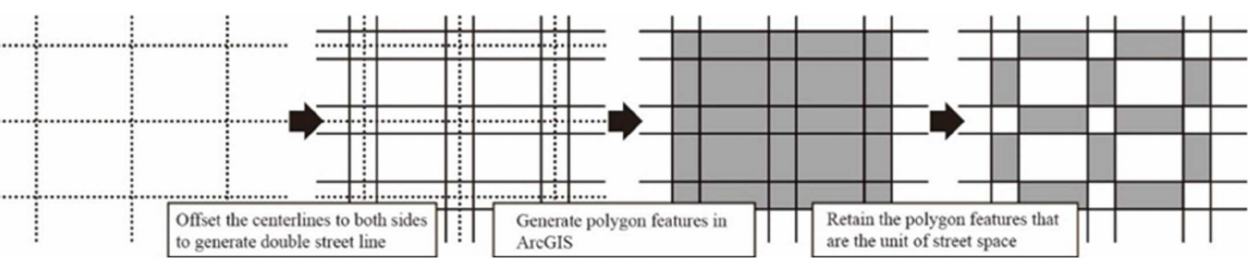
Figure 4. Delineation of street space and division of spatial